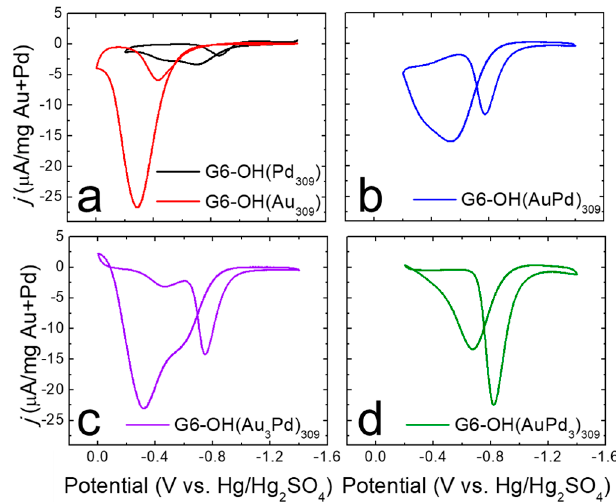
Figure 3. Electrocatalytic EOR CVs for ( a ) G6-OH(Pd 309 ) and G6-OH(Au 309 ); ( b ) G6-OH(AuPd) 309 ; ( c ) G6-OH(Au 3 Pd) 309 ; and ( d ) G6-OH(AuPd 3 ) 309 DENs. The CVs were carried out at a scan rate of 50 mV/s in a N 2 -satd., 1.0 M KOH solution containing 0.50 M ethanol. Electrocatalytic EOR CVs were background subtracted using the background CVs shown in Figure S1.